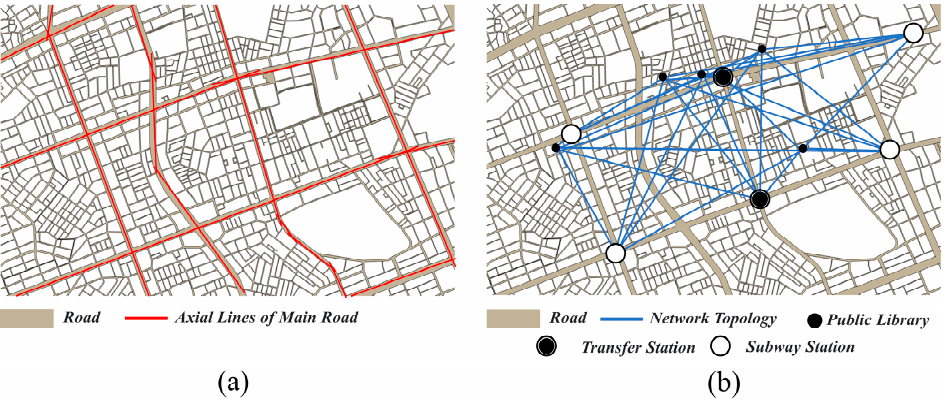
Figure 3. Example of creating an axial map and convex space in an area of Gangnam-gu, Seoul: ( a ) the axial lines represent major roads; ( b ) a convex space topological structure of public libraries around a subway station within a 2000 m radius.